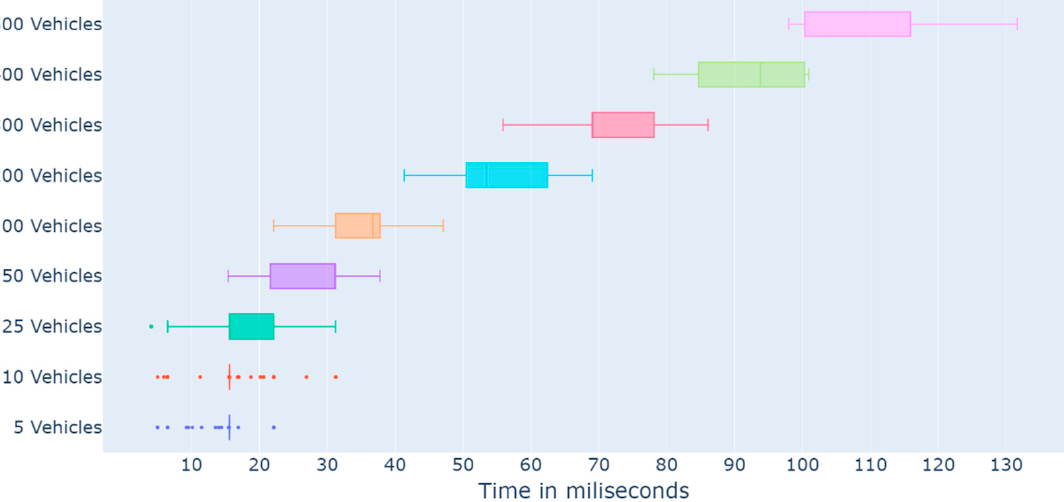
Figure 10. Box plot with insertion time into Neo4j in milliseconds of different number of vehicles.